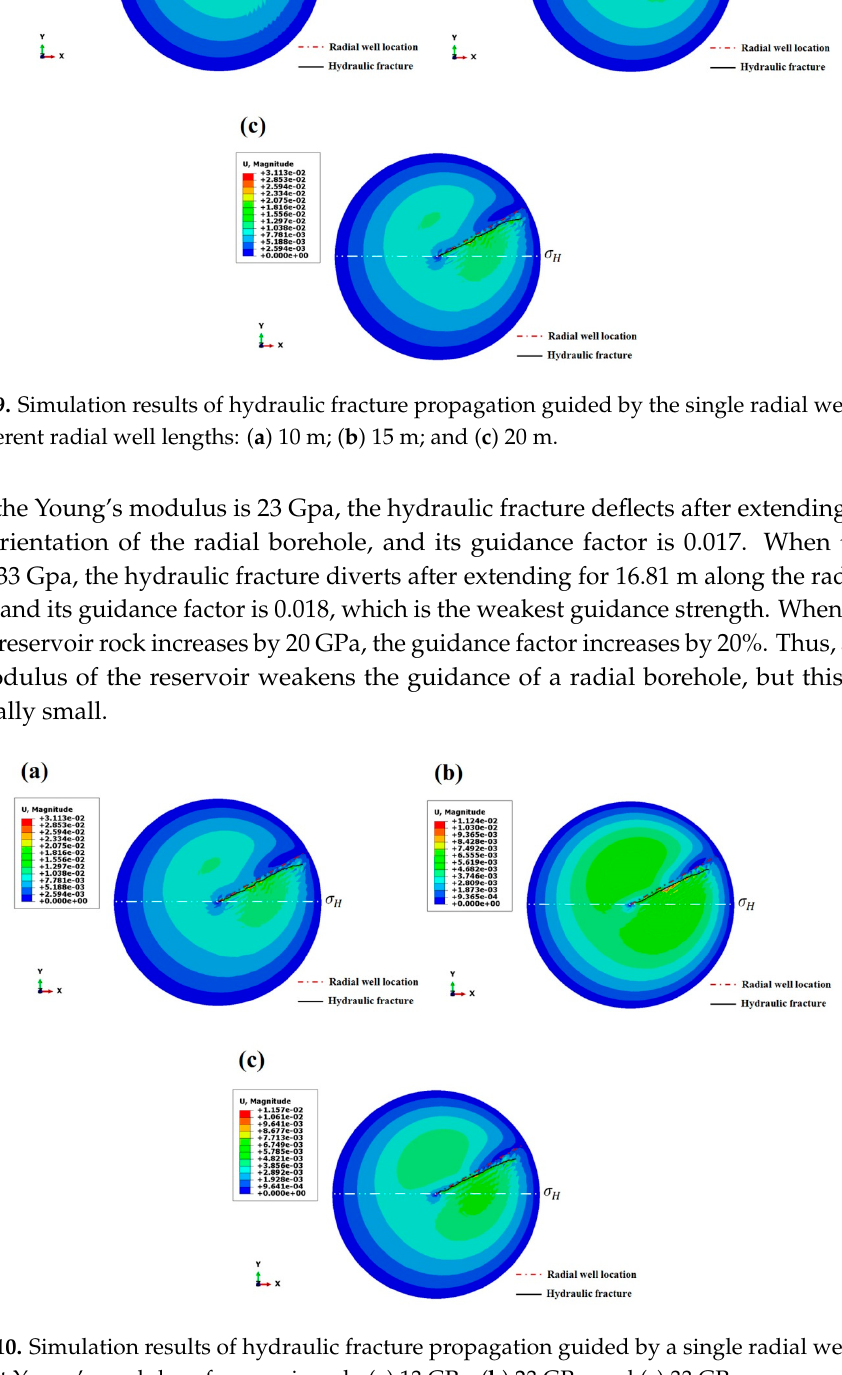
Figure 10. Simulation results of hydraulic fracture propagation guided by a single radial well under different Young’s modulus of reservoir rock: ( a ) 13 GPa; ( b ) 23 GPa; and ( c ) 33 GPa.